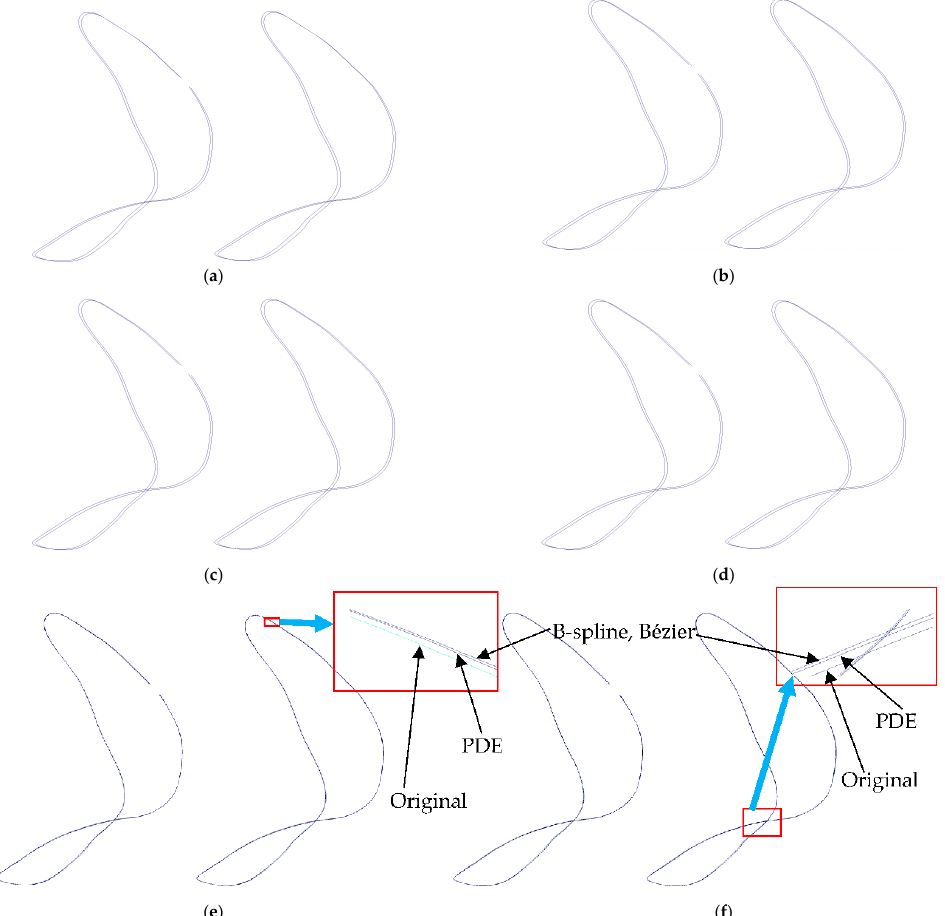
Figure 4. Original and reconstructed curves with 67 points at 37th and 38th frames. ( a ) Original curves at 37th, 38th frames. ( b ) PDE reconstructed curves at 37th, 38th frames. ( c ) B-spline reconstructed curves at 37th, 38th frames. ( d ) Bézier reconstructed curves at 37th, 38th frames. ( e ) Original, PDE, B-Spline, and Bézier curves at 37th frame. ( f ) Original, PDE, B-Spline, and Bézier curves at 38th frame.